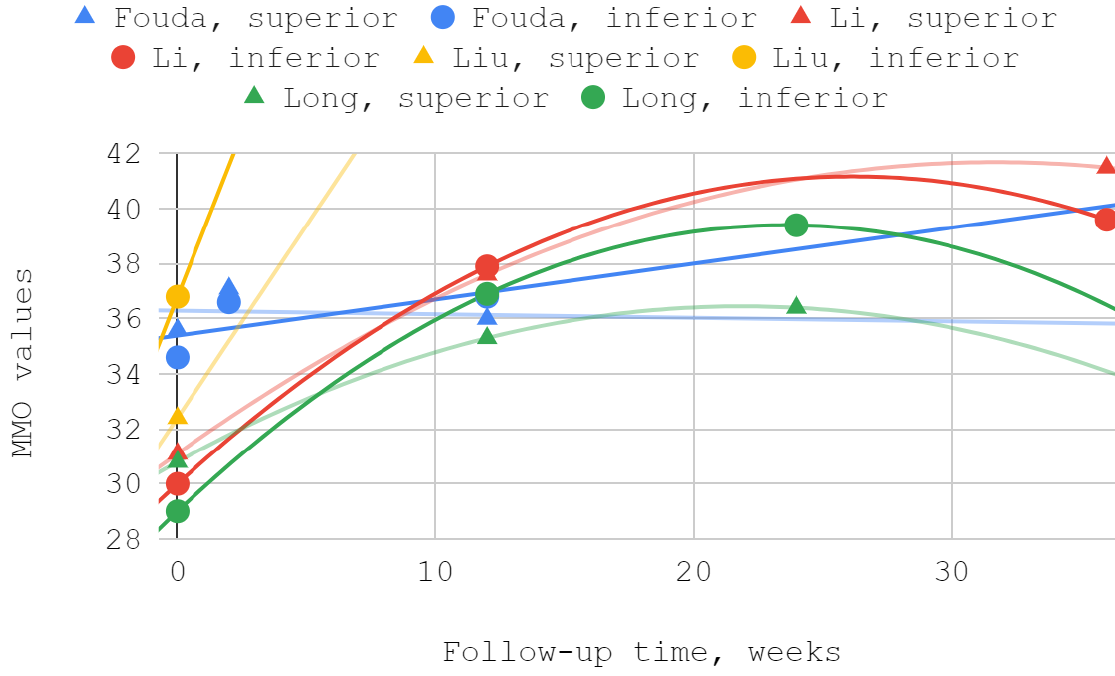
Figure 6. Maximum mouth opening (MMO) over time — chart fragment close-up .